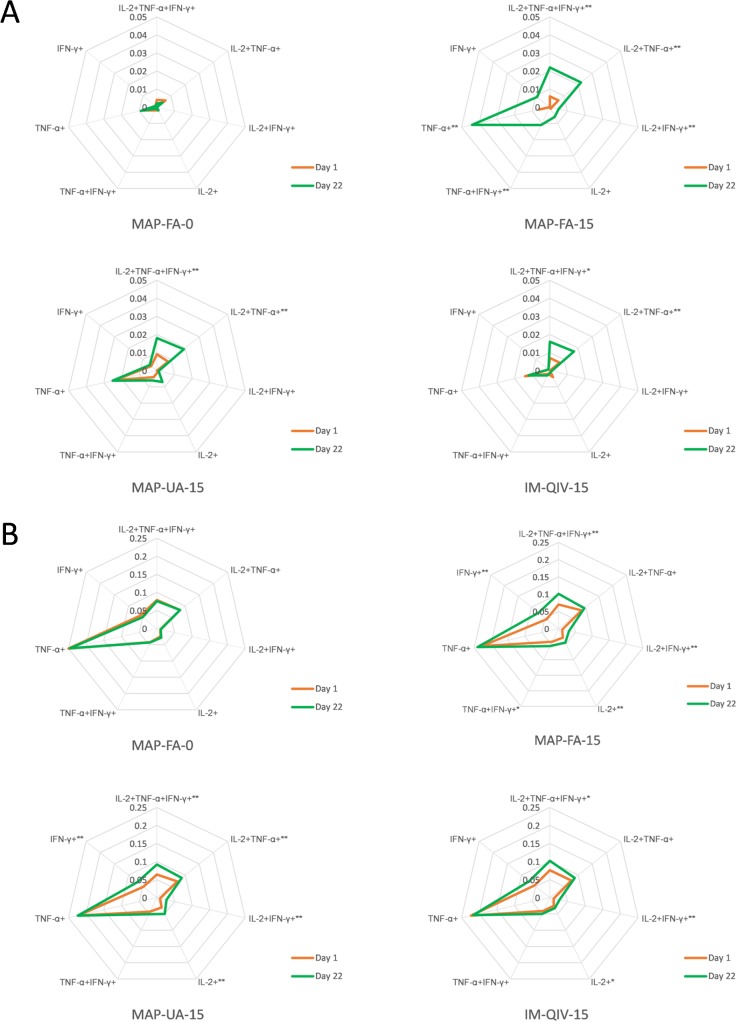
Frequency of CD4+
cells producing IL-2, TNF-α, or IFN-γ following stimulation of PBMC with (A) overlapping peptides spanning A/Sing HA (5 μg/ml) or (B) A/Sing MPH (20 μg/ml). Cells were labelled with Live/Dead Aqua for viability; CD3, CD4, and CD8; permeabilised; and subsequently labelled with anti-IFN-γ, anti-TNF-α, and anti-IL-2. Approximately 500,000 events were acquired using a Becton Dickinson LSR Fortessa X20 and data analysed using SPICE software. Day 1 versus day 22 comparisons were made using the Wilcoxon rank sum test: **p < 0.01, *p < 0.05. HA, haemagglutinin; IFN, interferon; IL, interleukinMPH, monovalent purified harvest; PBMC, peripheral blood mononuclear cell; TNF, tumour necrosis factor.